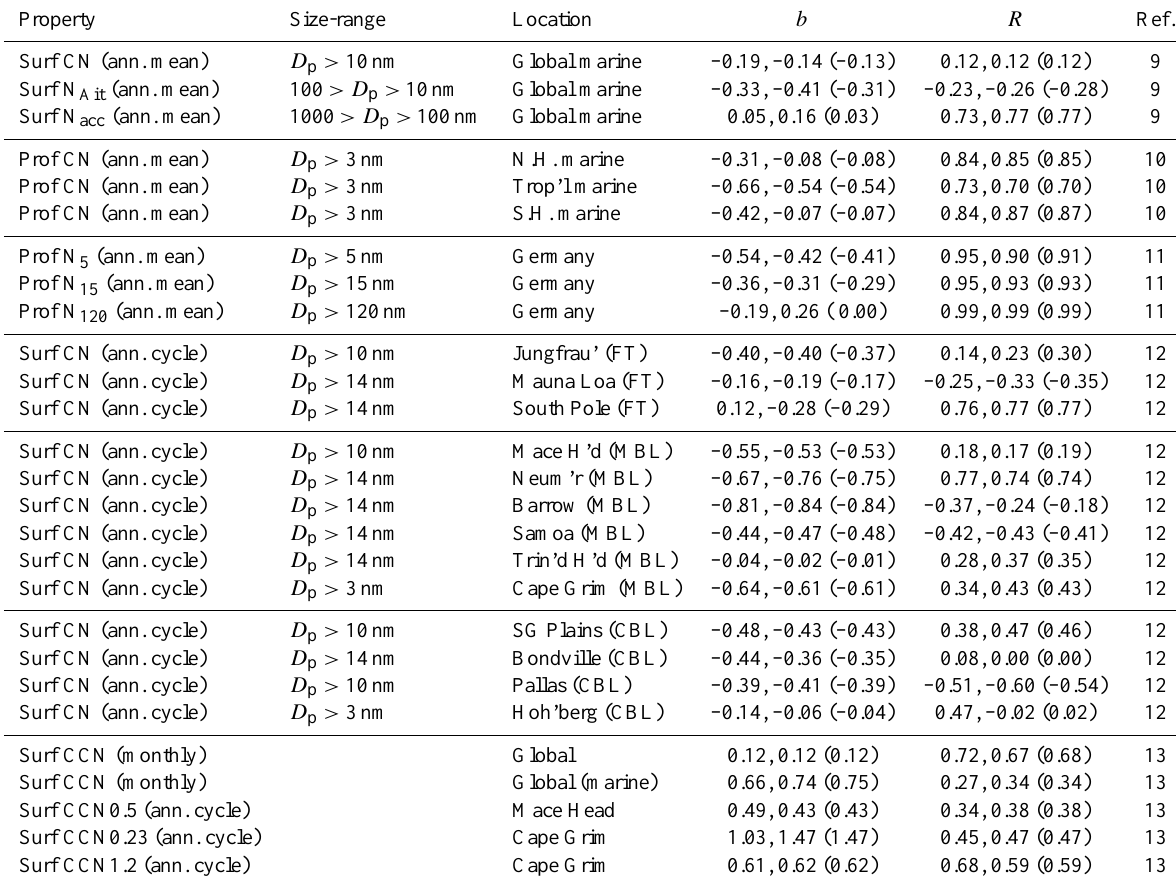
Table 5. Simulated CN, CCN and size-resolved number concentrations for bin and mode, respectively (comma-separated) against each of the benchmark observational datasets. Normalised mean bias ( b ) and Pearson correlation coefficient ( R ) are shown. The GLOMAP-mode run with the original accumulation mode standard-deviation and mode-edge radius is shown in parentheses. References for the